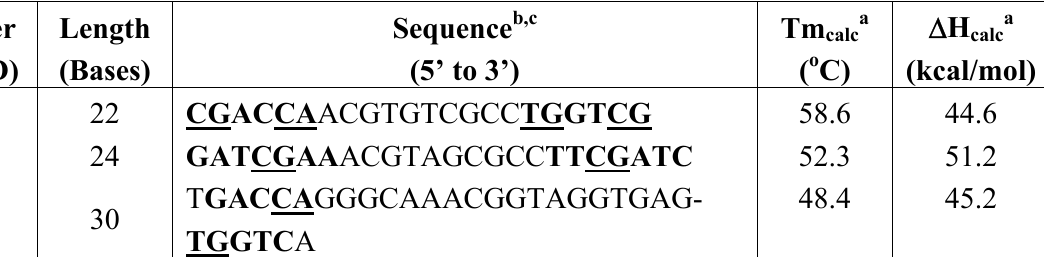
Table 1. L-argininamide binding DNA aptamers